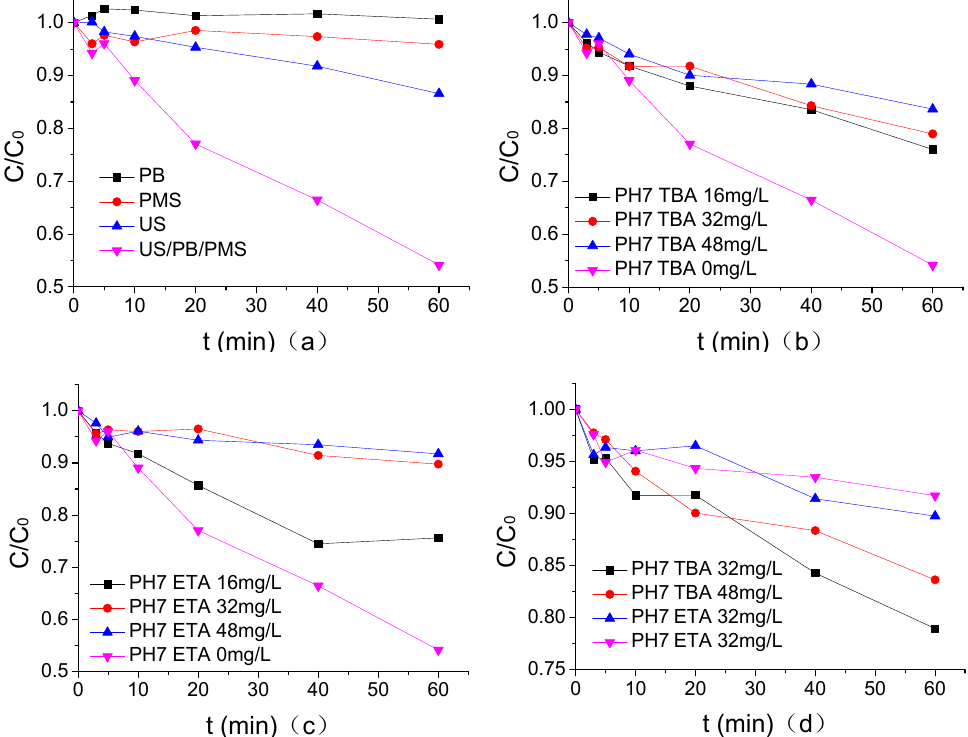
Figure 6. ( a ) The analysis of the oxidation effect of each component in the US/PMS system. ( b ) The effect of TBA on the degradation of ATZ by US/PMS in PB at pH 7. ( c) The effect of ETA on the degradation of ATZ by US/PMS in PB at pH 7. ( d ) The Comparison of TBA and ETA on US/PMS degradation ATZ at a pH of 7. The initial concentration of C 0 is 1.25 μ mol/L.